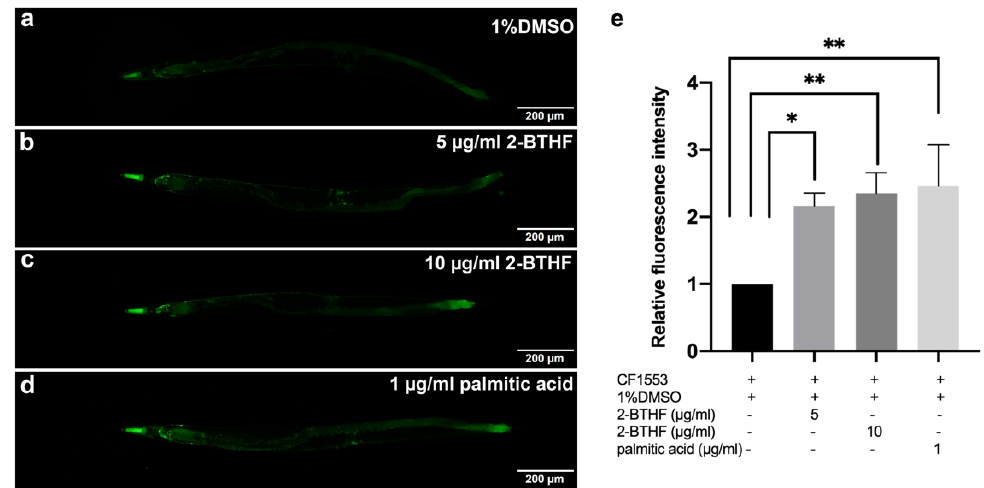
Figure 6. Effects of purified H. scabra compounds on SOD-3 expression in transgenic CF1553 strain. GFP expression in the worms treated with 1% DMSO (control) ( a ), 5 µ g/mL 2-BTHF ( b ), 10 µ g/mL 2-BTHF ( c ), and 1 µ g/mL palmitic acid ( d ) extracts are shown. The relative fluorescence intensity of sod-3p:: GFP was quantified and shown ( e ). The results of SOD-3 GFP expression were analyzed by one-way ANOVA following Bonferroni’s method, * p < 0.05 and ** p <